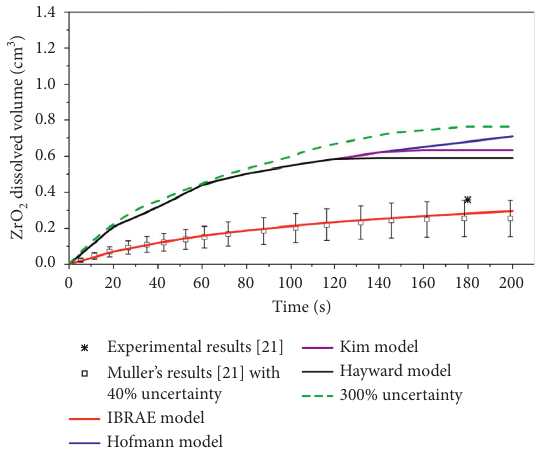
Figure 10: Comparison of dissolved ZrO models at 2200 ° C.